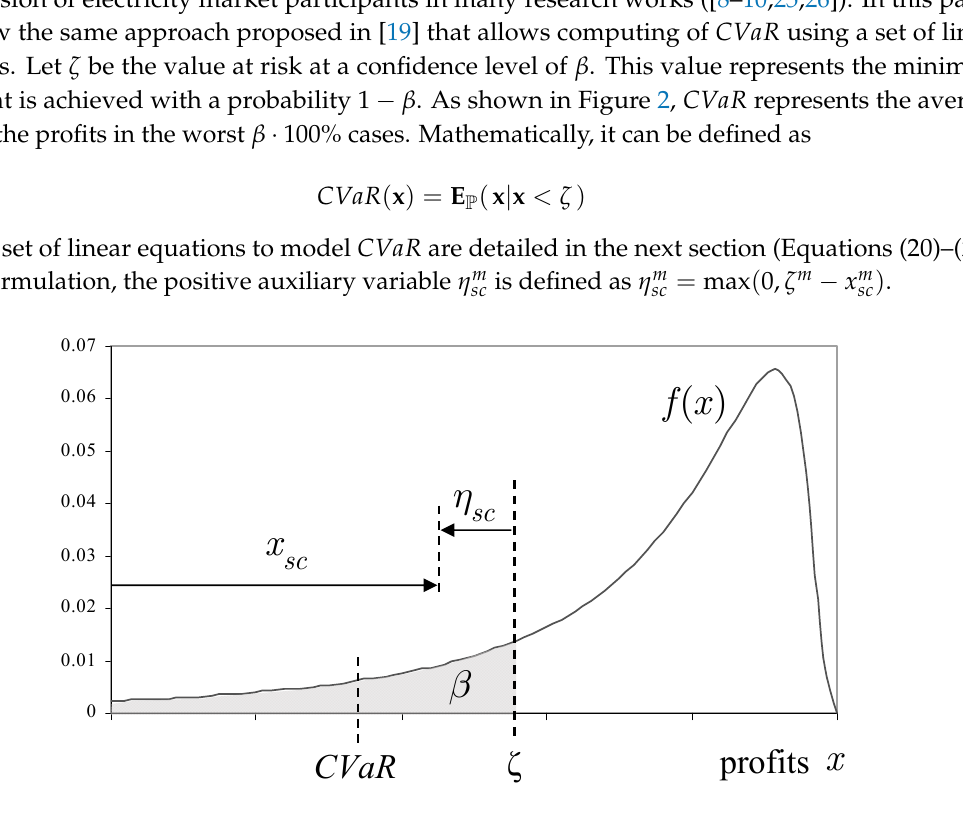
Figure 2 . Profits distribution, value at risk ( z ), and conditional value at risk ( CVaR ). Figure 2. Profits distribution, value at risk ( ζ ), and conditional value at risk ( CVaR